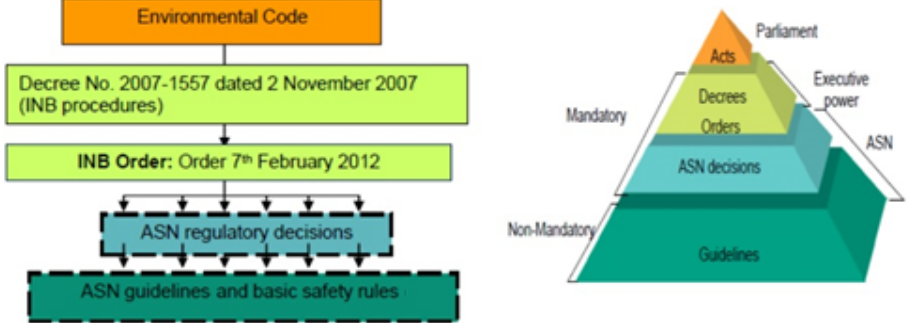
Figure 4. Main French regulations applicable to ITER.